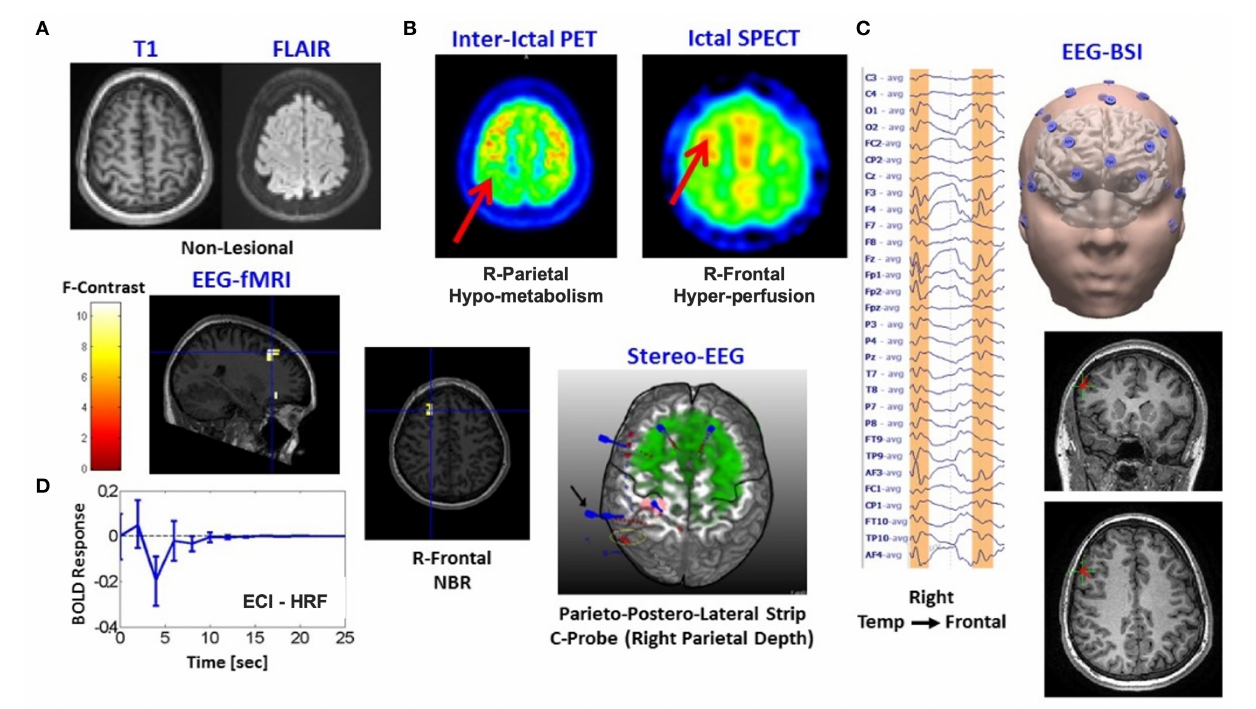
FIGURE 5 | Patients #2 shows an irritative zone with ECI-type HRF with a high probability to be the seizure onset zone. (A) Two modalities of fMRI anatomical imaging: left, T1-weighted; right, FLAIR. (B) Two modalities of nuclear imaging: left, interictal PET; right, ictal SPECT. (C) Left, Ictal EEG points out to a bifrontal spike/slow wave at 3-4Hz; right, brain source imaging (EEG-BSI) in Right Tempo-Frontal. (D) Composed panel: left top and center, two slices with the thresholded F-statistics map built from the estimated coefficients of the GLM overlaid on the T1-weighted image with blue crosshair locating the center of one NBR region in the Right Frontal Lobe, left bottom-estimated NN-ARx of this particular NBR-HRF was classified as ECI mechanism, right-stereo EEG (sEEG) electrodes placement is shown as